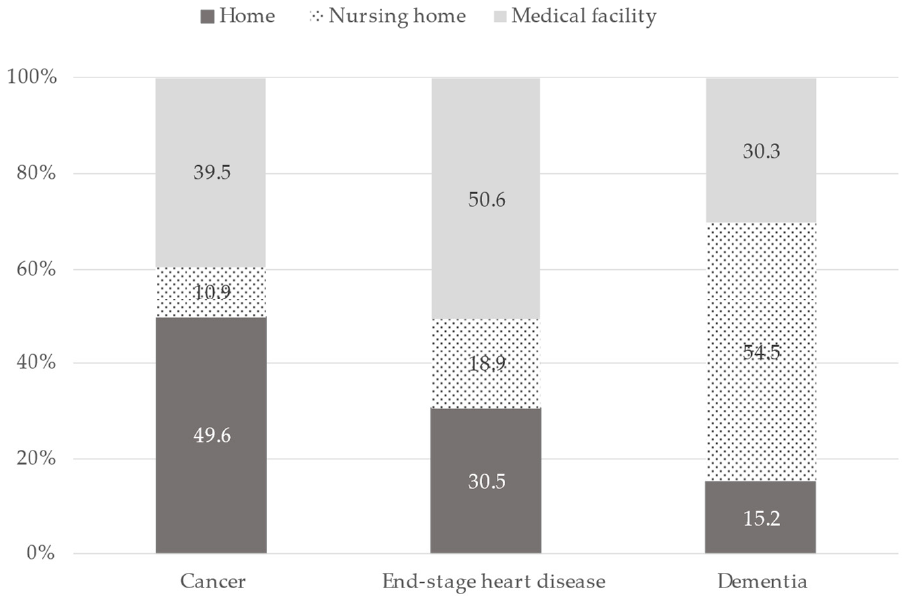
Figure 2. Proportion of preferred place of care by assumed clinical scenario, N = 889.